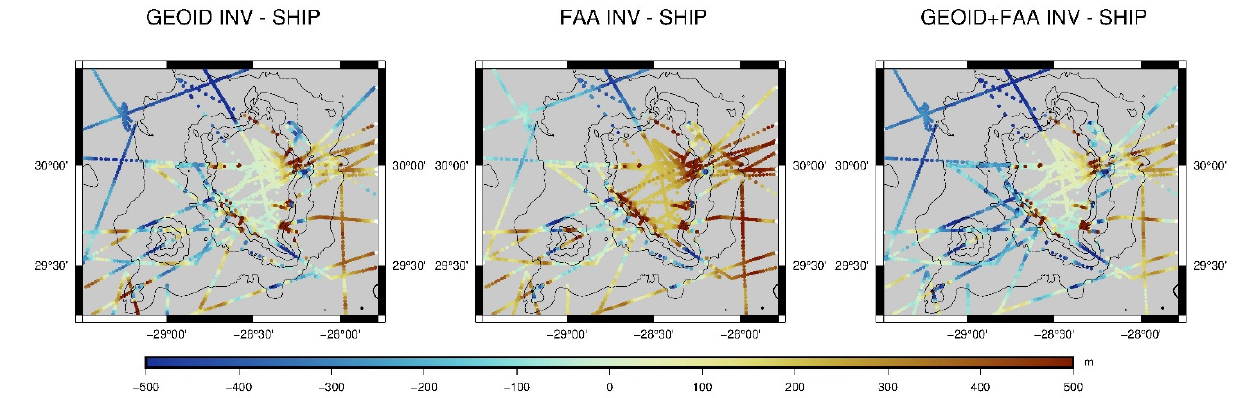
Figure 11. Differences between EKF estimates and ship-track bathymetry. Table 1. Values of Global Bathymetric Models minus ship-track soundings and EKF solutions minus ship-track soundings. Units are